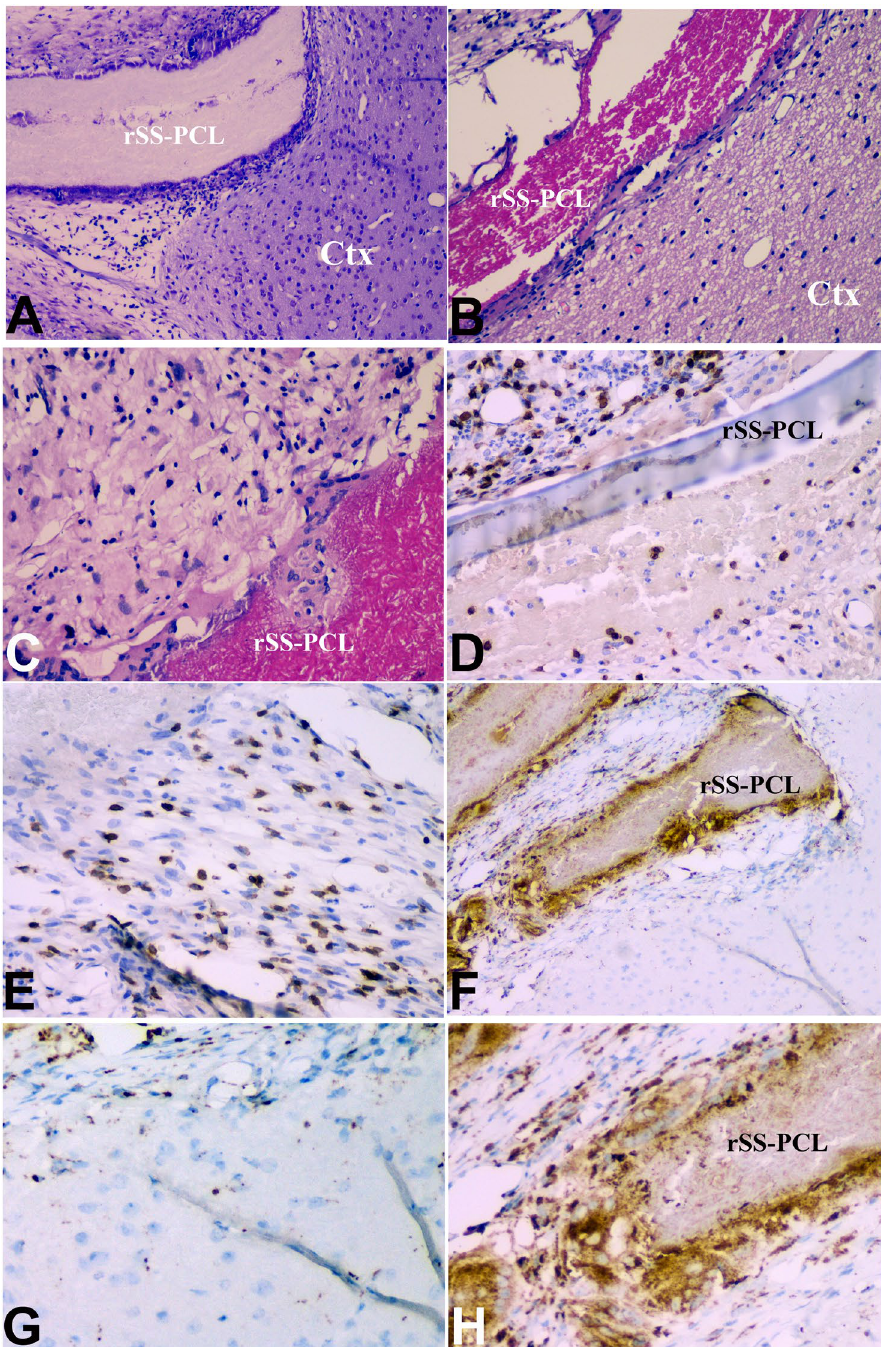
Figure 6. Histological and immunohistochemical (IHC) analysis of the endogenous immune response to the drNPC-SPRPix implanted into the brain cortex of a rhesus macaque. ( A ) Nissl stain; magnification × 100 ( B , С ). H&E stain of the interface between the SPRPix and the surrounding host tissue; magnifications × 100 ( B ) and × 200 ( С ). ( D , E ). Representative images of CD3 staining showing low level of T cell infiltration in the brain tissue adjacent to the drNPC-SPRPix implant. ( F – H ) Representative images of CD68 staining showing examples of microglial/macrophages in the brain adjacent to the drNPC-SPRPix implant ( G ) and among the human cell graft ( H ). ( E , H ) depict the areas with the highest immune cell infiltration noted. Bar size 100 µ m. Notations: rSS-PCL-spidroin-polycaprolactone scaffold; Ctx – brain